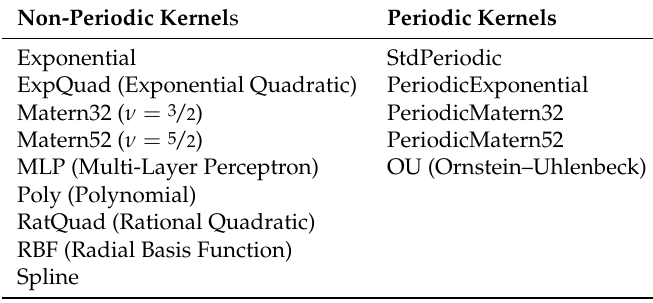
Table 1. The kernels from the GPy library that were used to create the